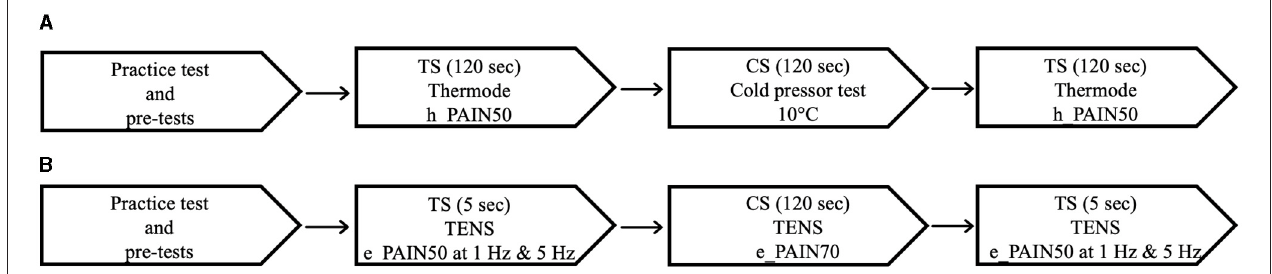
FIGURE 1 | Testing sequence of the thermode/CPT protocol (A) and the TENS protocol (B) . CPT, cold pressor test; TENS, transcutaneous electrical nerve stimulation; CS, conditioning stimulus; TS, test